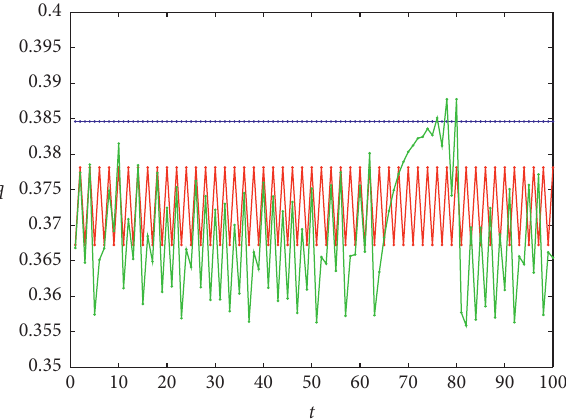
Figure 7: When α